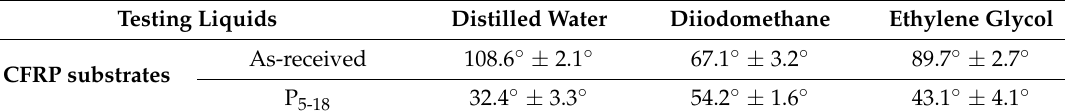
Table 8. Measured contact angles of the as-received and P 5-18 CFRP substrates.